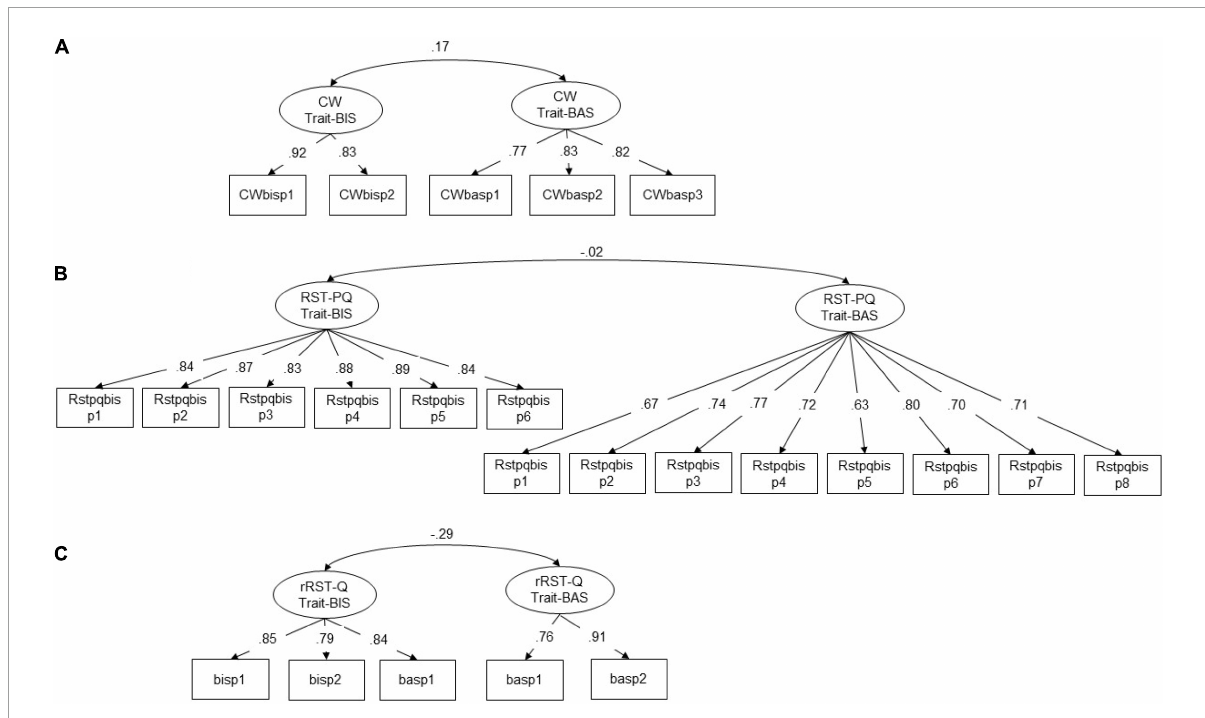
FIGURE1 Standardized factor loadings (STDYX) of two-factor models for the Carver-White (CW) BIS/BAS questionnaire (A) , RST-PQ (B) , and Reuter-Montag (RM) rRST-Q (C) . p1–p8, parcel 1–parcel 8. All p -values p < 0.01, two-tailed.